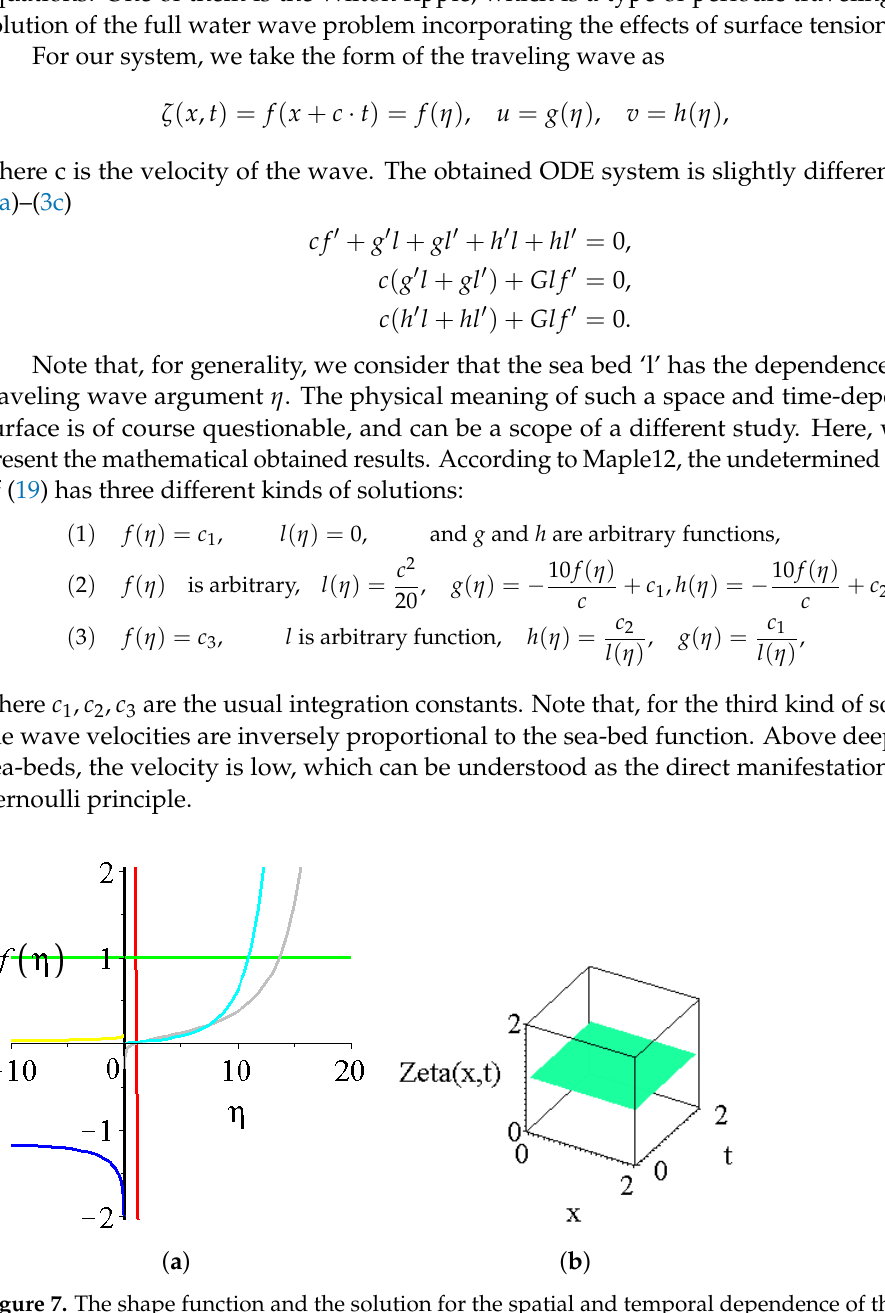
Figure 7. The shape function and the solution for the spatial and temporal dependence of the wave height. ( a ) the shape function of wave height f ( η ) for various α s for time-dependent linear seabed functions. The black, red, blue, green, yellow, gray and cyan colours are for α = − 2, − 1, − 1/2,0,1/2,1 and for 2, the geometrical constants are a = b = 1 and c = 0; ( b ) the spatial and temporal dependence of the water wave height ζ ( x , y = 0, t ) for α =